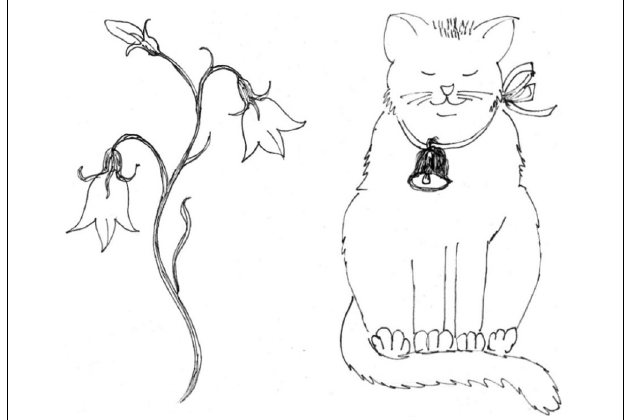
FIGURE 2 | Example of the word stress task. The left picture represents a compound word “kissankello” and the right picture a phrase “kissan